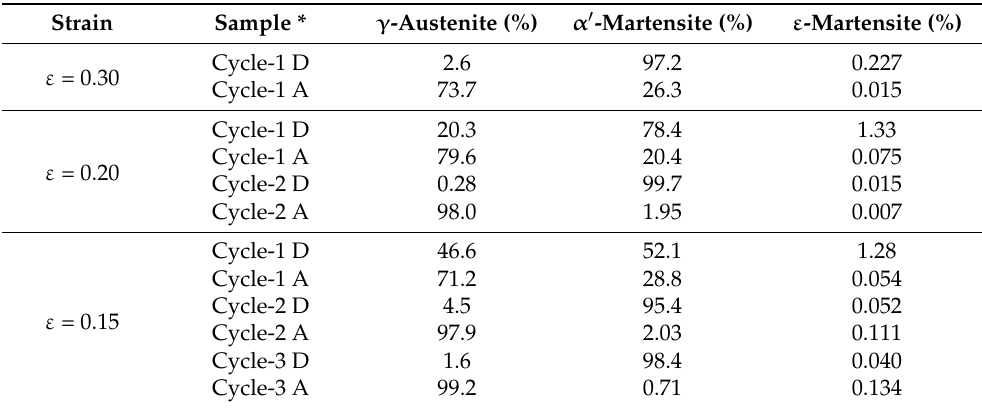
Table 2. Volume fraction of phases (%) for TMP samples processed. Strain Sample